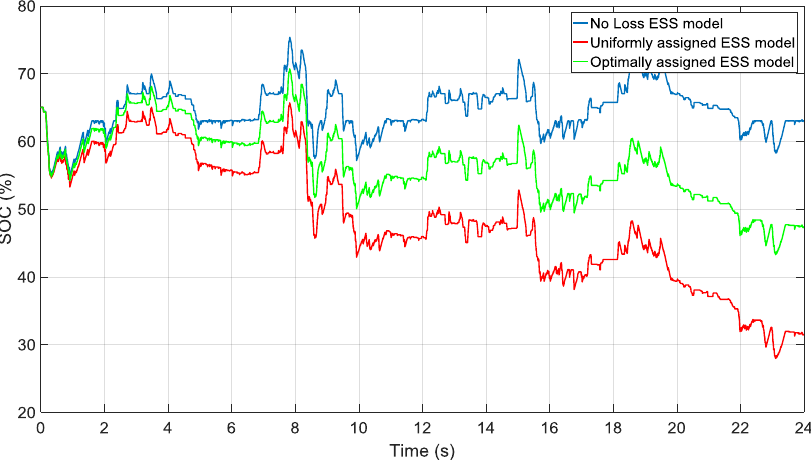
Figure 11. Comparison of SOC change according to ESS operation model.